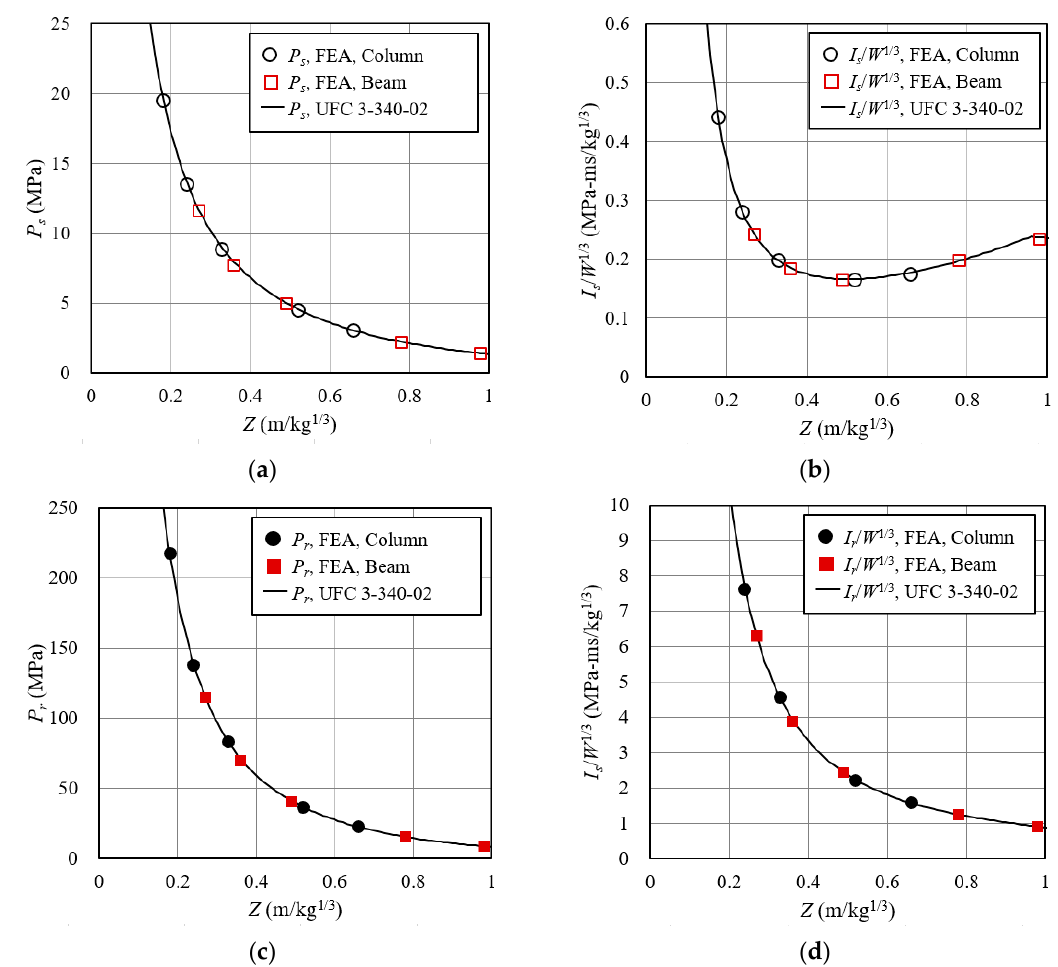
s ; ( b ) I s ; ( c ) P r ; ( d ) I r